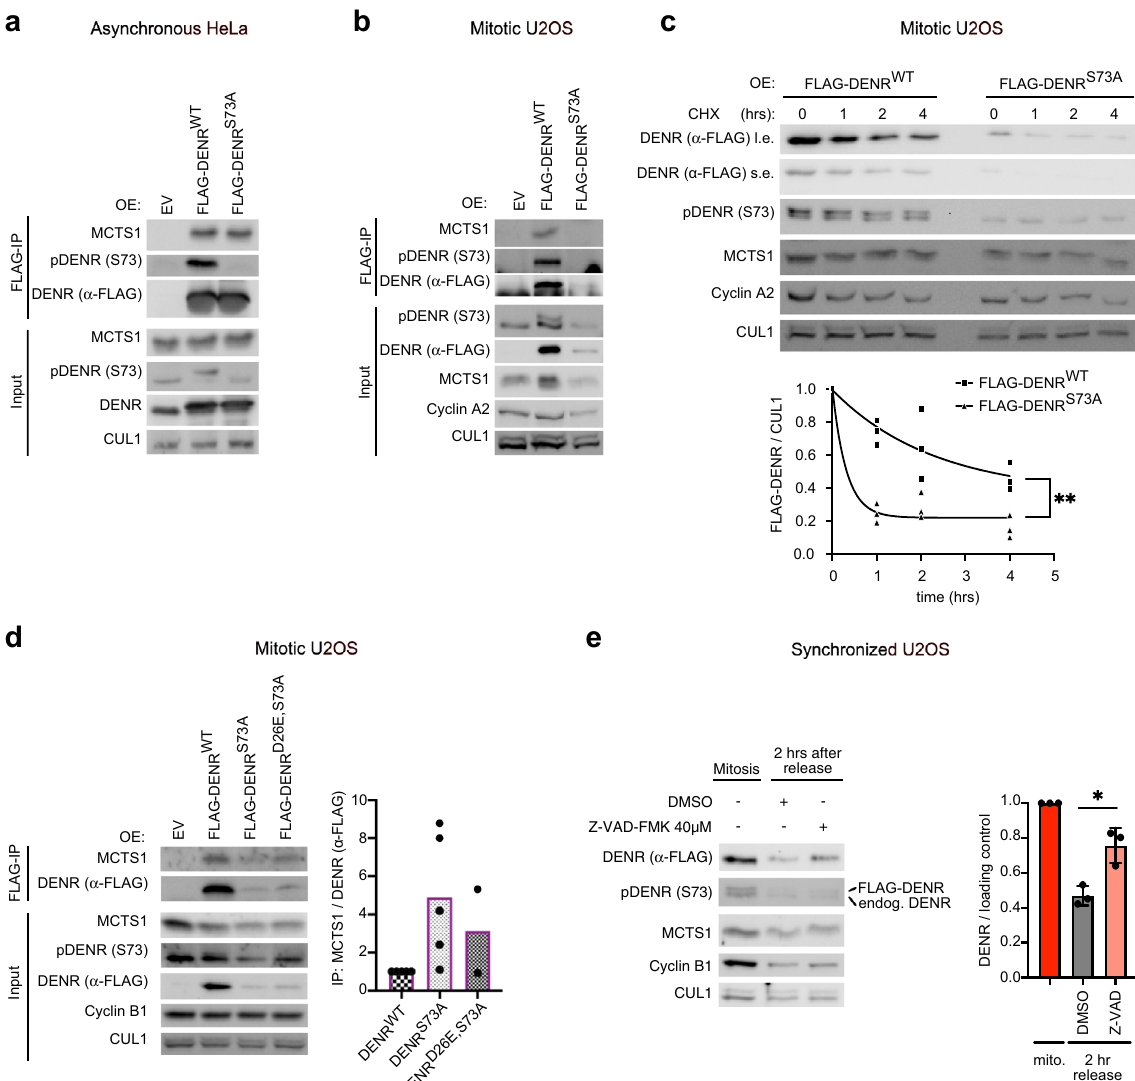
Fig. 3 Ser73 phosphorylation protects DENR from mitotic degradation. a Immunoprecipitation of overexpressed FLAG-DENR WT or FLAG-DENR S73A from asynchronous HeLa cells shows MCTS1 binding to both DENR versions. The Western Blot shown is representative of n = 3 independent biological replicates. b Immunoprecipitation of overexpressed FLAG-DENR WT or FLAG-DENR S73A from mitotically synchronized U2OS cells shows a strong loss of DENR S73A protein. The Western Blot shown is representative of n = 3 independent biological replicates. c FLAG-DENR S73A is less stable than FLAG- DENR WT in mitotic U2OS cells. Cells were transfected to express either version of DENR, then synchronized in mitosis, harvested by shake-off, and fi nally exposed to cycloheximide for the indicated times and analyzed by Western Blot. Quanti fi cation of FLAG signal normalized to CUL1 from n = 3 independent biological replicates. Nonlinear regression lines are shown and Extra sum-of-squares F test of one phase decay constant ( K ) was performed with ** p = 0.009. d Partial restabilization of DENR by the D26E mutation re-establishes binding to MCTS1 in mitotic U2OS cells. This experiment was performed as described in b using in addition the non-phosphorylatable, non-cleavable mutant DENR D26E,S73A and STLC instead of nocodazole as a mitotically synchronizing agent. Right panel: quanti fi cation of MCTS1 binding to DENR versions. n = 5 independent biological replicates for DENR WT and DENR S73A and n = 2 for DENR D26E,S73A . e Destabilization of DENR at mitotic exit is partly caspase-dependent. U2OS cells expressing a FLAG-DENR WT cDNA construct were synchronized in mitosis (red) and then released from mitosis after addition of DMSO (gray) or the pan caspase inhibitor Z-VAD- FMK 40 μ M (light-red). Samples were collected at the time of release (before addition of DMSO or Z-VAD-FMK) or 2 h later and analyzed by Western blot. Quanti fi cation of total FLAG-DENR signal using ImageJ (v1.50i or 1.53c), normalized to CUL1 and then to the 0 h time point from n = 3 independent biological replicates is shown. Error bars indicate standard deviations and unpaired t -test was performed with * p = 0.01.